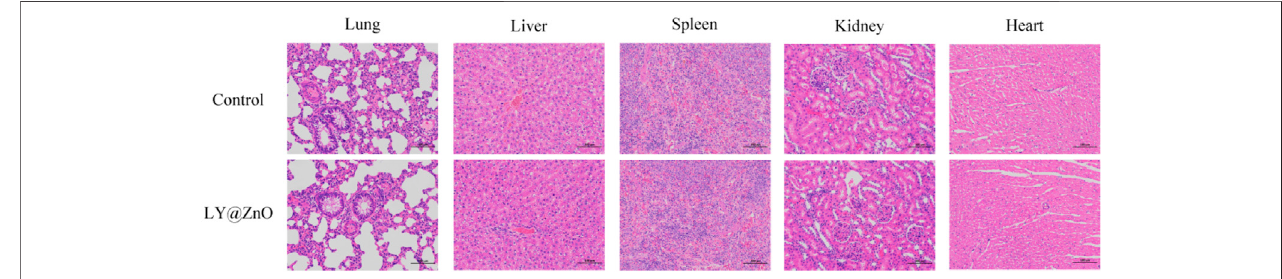
FIGURE 14 | Cell viability of LO2, BEAS-2B, CATH.a, H9C2, and MA104 with the treatment of 0.0, 5.0, 10.0, and 20.0 mg/L LY@ZnO, 20.0 mg/L LY, and 20.0 mg/L ZnO.